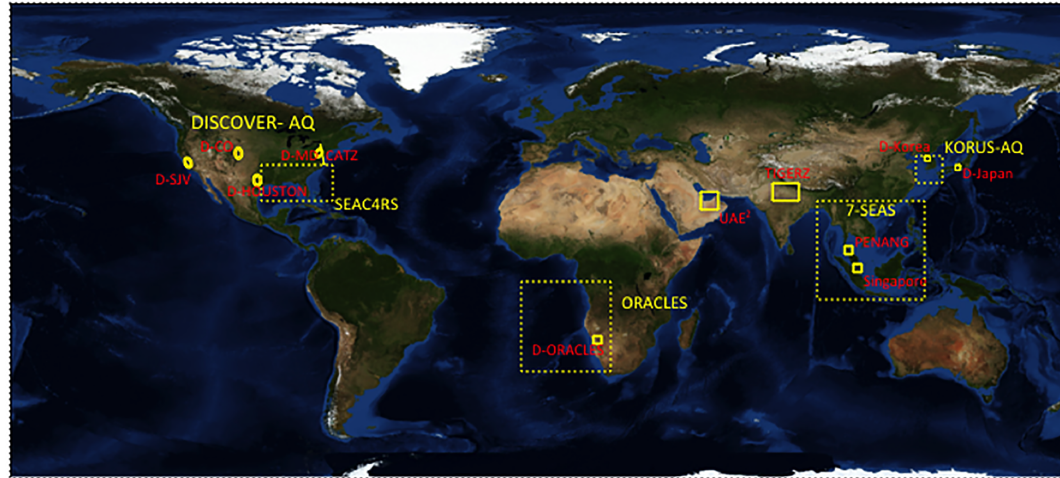
Figure 1. The distribution of DRAGON campaigns conducted from 2004 to 2016 are framed in yellow with red labels. Yellow labels indicate larger campaigns with dashed frames that include DRAGON